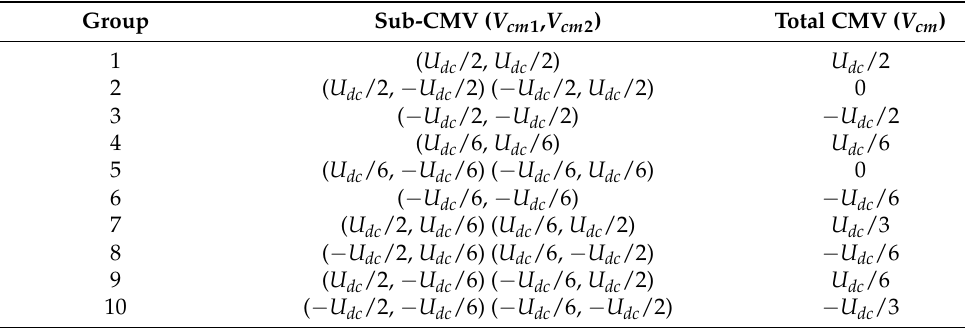
Table 3. The combinations of sub-CMV and total CMV for six-phase